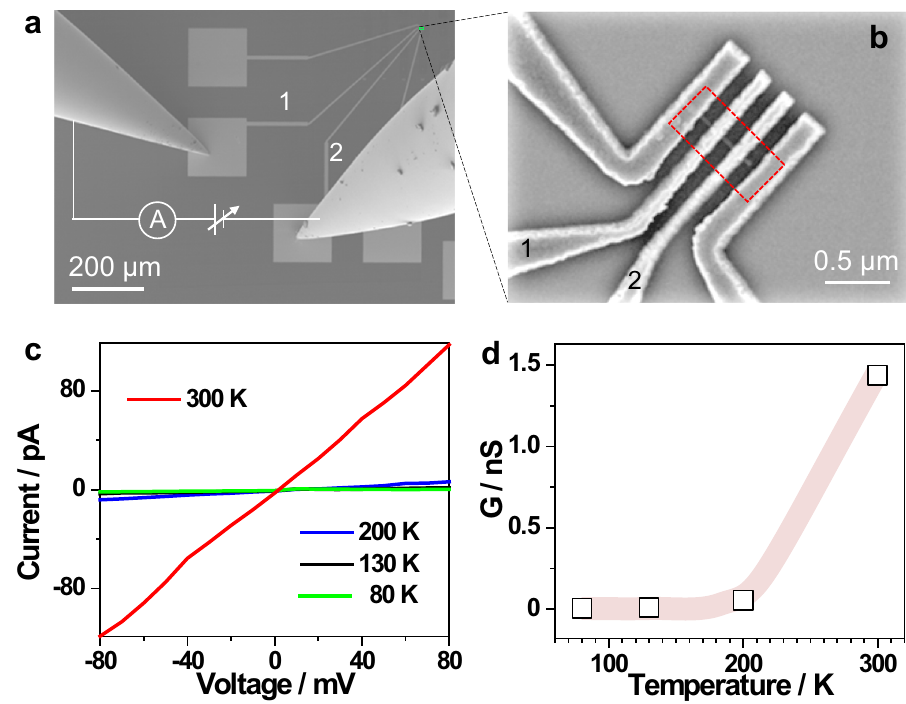
Fig. 5 Electrical properties of ASWs. a Circuit setup for the I – V measurements of ASWs. b An ASW array bridged between the nanoelectrodes (labeled as 1 and 2, highlighted in a red dashed rectangle), which was enlarged from the green rectangle in a . c The I – V curves of the ASW at different temperatures. d The corresponding conductance (G) of the array calculated from the slopes of the I – V curves ( c